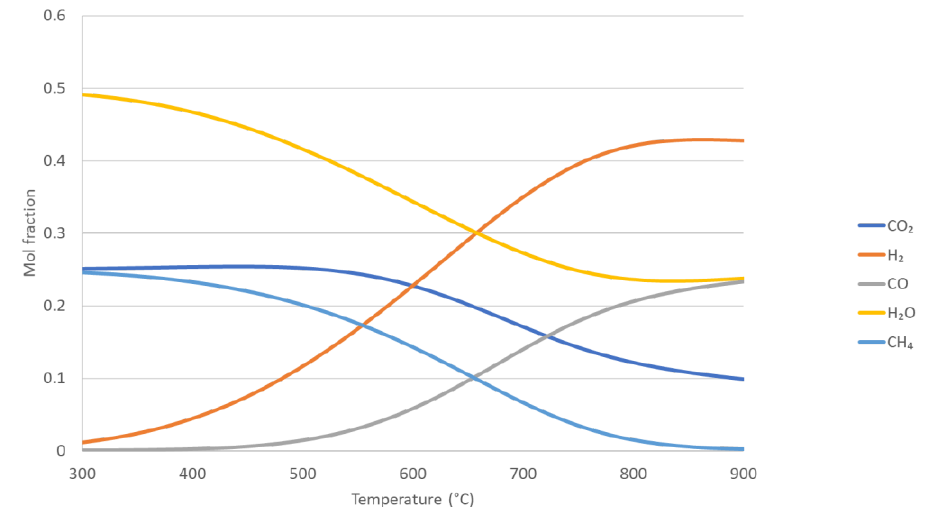
Figure 1. Thermodynamic equilibrium molar fractions of the reverse water gas shift reaction at different temperatures. H 2 /CO 2 ratio = 2, P = 6 bar. Calculated with Outotec HSC Chemistry 9 Equilibrium compositions calculator, using HSC DB9 database.